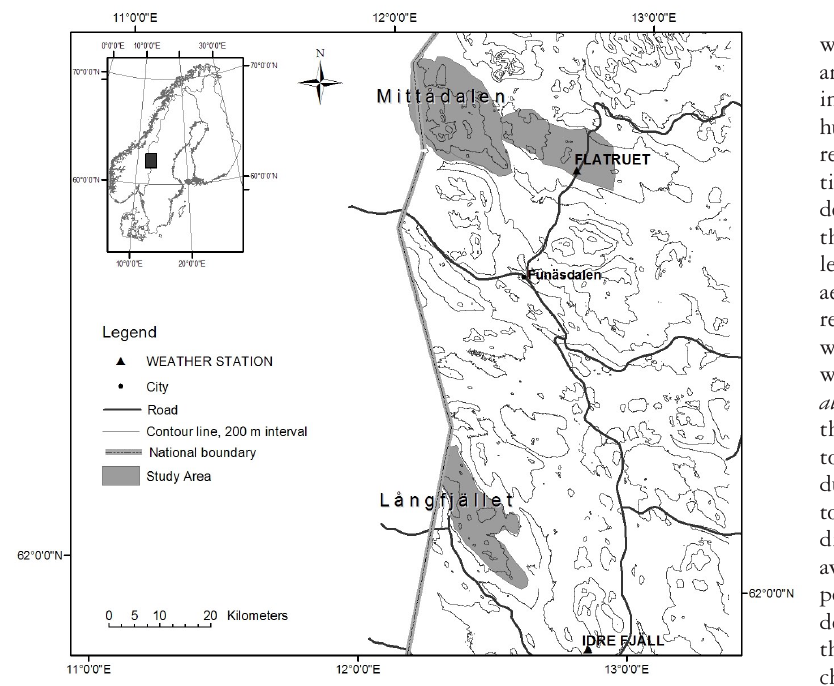
���������������������� Fig. 1. The map shows the locations of the two study areas (grey) Långfjället in Idre, and the open area in Mittådalen reindeer herding districts. The elevation lines shown have an equidistance of 200 m starting at 600 m of elevation. The map also shows the positions of the two weather stations Flatruet and Idre Fjäll ( ▲